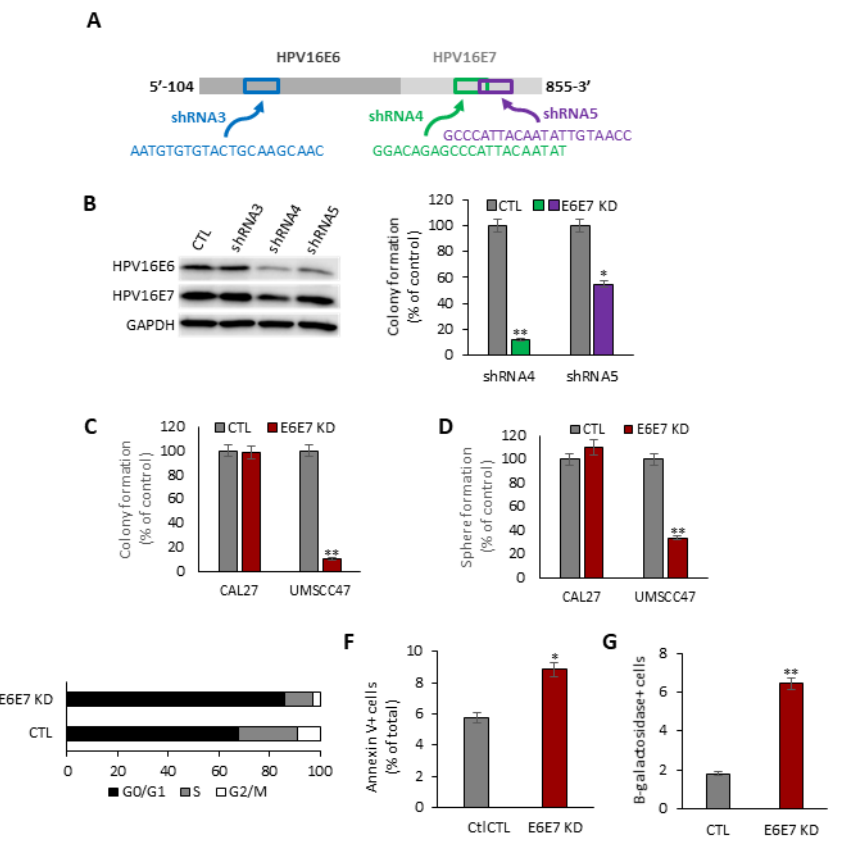
Figure 1. Inducible HPV16E6E7 knockdown drives a pleotropic anti-cancer effect in HPV16+ SCC cells. ( A ) Design of short hairpin RNA (shRNA) constructs targeting HPV16E6 or HPV16E7. ( B ) Validation of shRNA constructs to target HPV16E6 and HPV16E7, and suppress colony formation. Immunoblot for HPV16E6 and HPV16E7 ( left ). Uncropped immunoblots are available in File S1. Colony formation assay ( right ). Number of colonies as a percentage of control (CTL) count for HPV16E6E7 knockdown (E6E7 KD) induced by shRNA constructs 4 and 5. * p < 0.05; ** p < 0.01. ( C ) Colony formation assay. Number of colonies as a percentage of CTL. ** p < 0.01. ( D ) Tumor- sphere formation assay. The number of tumorspheres is shown as a percentage of the CTL count. ** p < 0.01. ( E ) Cell cycle analysis. Black, gray, and white bars indicate the percentage of the total population in each cell cycle phase for CTL and HPV16E6E7 KD cells. ( F ) Apoptosis assay. Percent- age of CTL and HPV16E6E7 UMSCC47 cells that are annexin V+ as measured by flow cytometry. * p < 0.05. ( G ) Senenscence assay. The percentage of CTL and HPV16E6E7 UMSCC47 cells that are B-galactosidase positive. ** p <